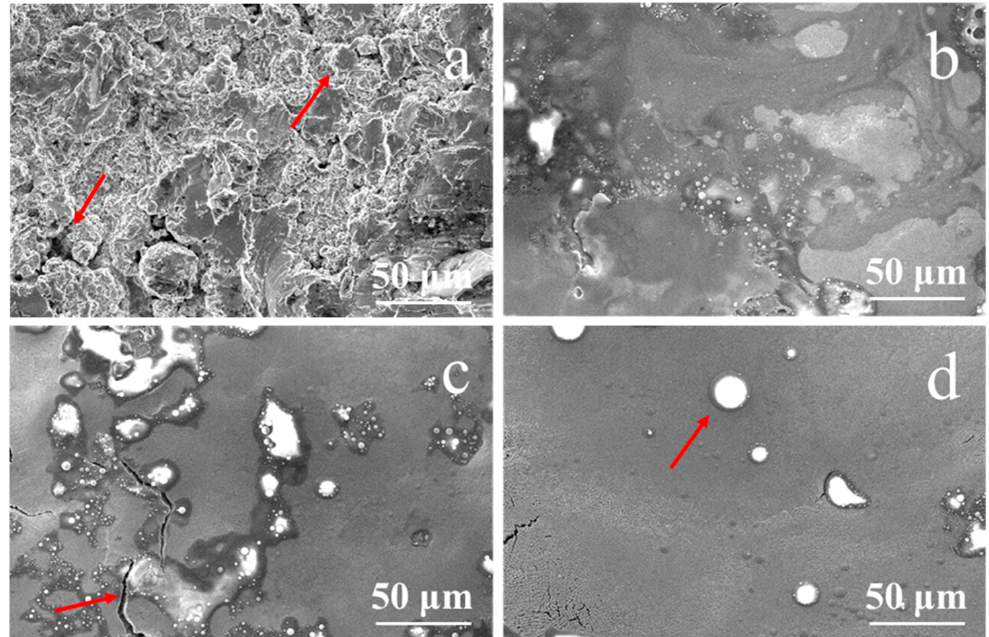
Figure 2. Surface morphology of the NiCrAlY bond coat before and after a high-current pulsed electron beam irradiation: ( a ) nonirradiated, the arrows point to the holes and cracks ( b ) 12 J/cm 2 ; ( c ) 15 J/cm 2 , the arrow points to a crack; ( d ) 18 J/cm 2 , the arrow points to a circular granular structure.